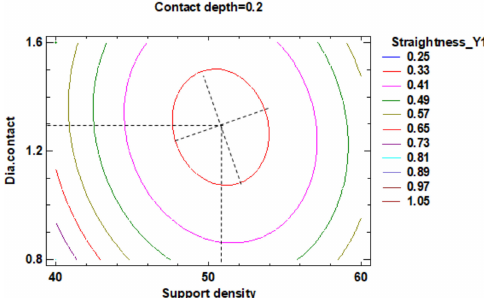
Figure 23. Contours of Estimated Response Surface for Straightness_Y1 and centre contact depth.